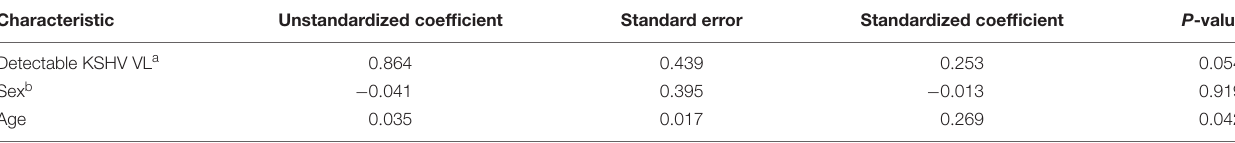
TABLE 4 | Multiple regression for PC1 severity in HIV negative COVID-19 positive patients ( n = 73). Characteristic Unstandardized coefficient Standard error Standardized coefficient P -value